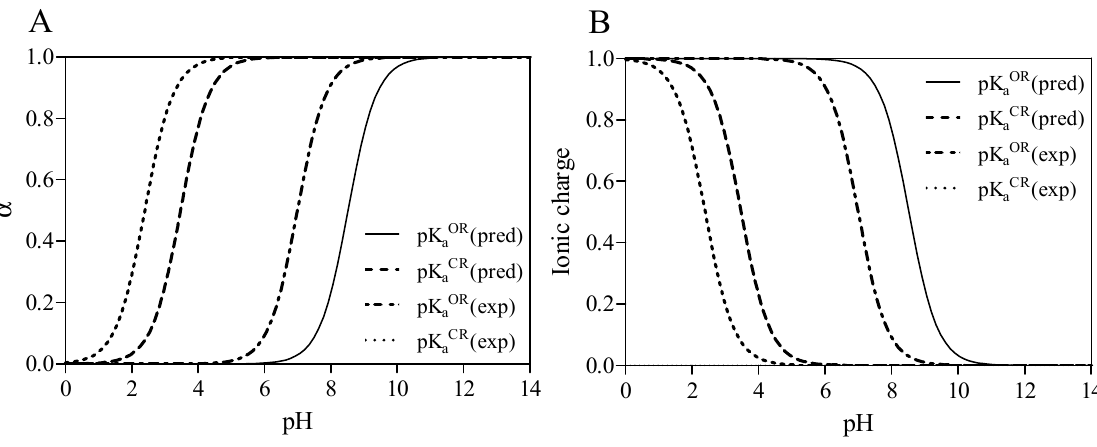
Figure 1. Calculated and experimentally derived degree of dissociation ( A ) denoted as α with ionic charge distribution ( B ) for the open-ring (OR) or closed-ring (CR) form of midazolam at different pH values according to Equations (1) and